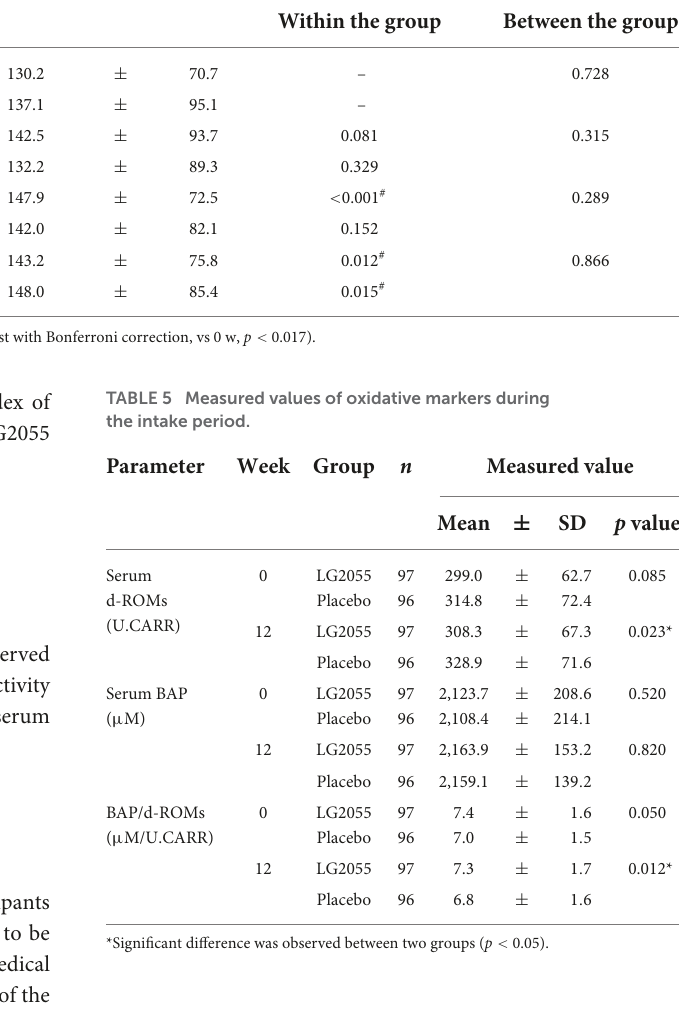
Within the group Between the group